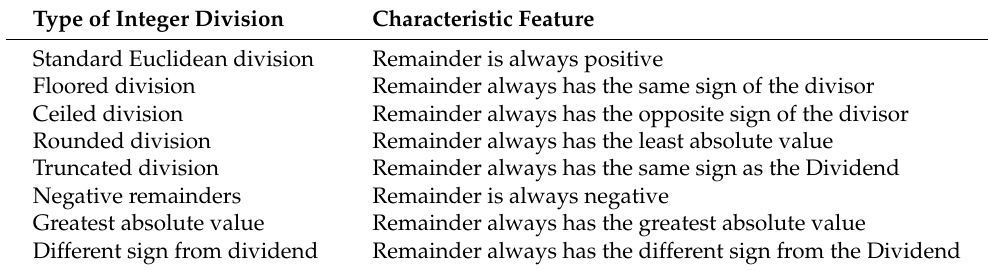
Table 1. Alternative ways for calculating the quotient when dealing with integer